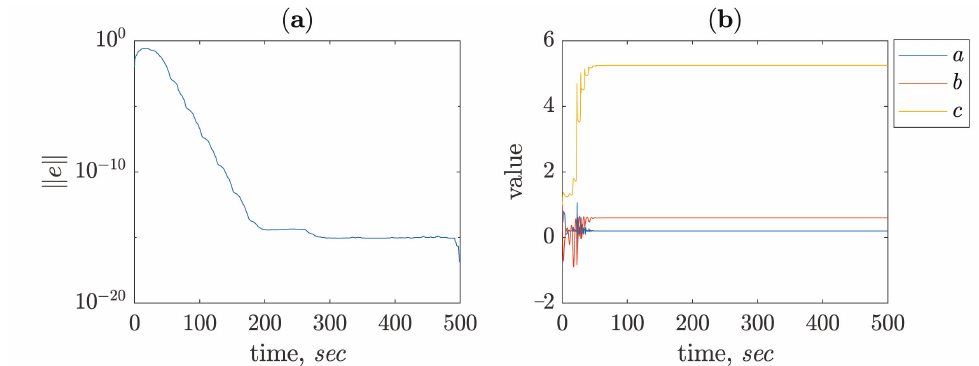
Figure 2. ( a ) Synchronization error between master and slave system. ( b ) Evaluation of parameters for the slave